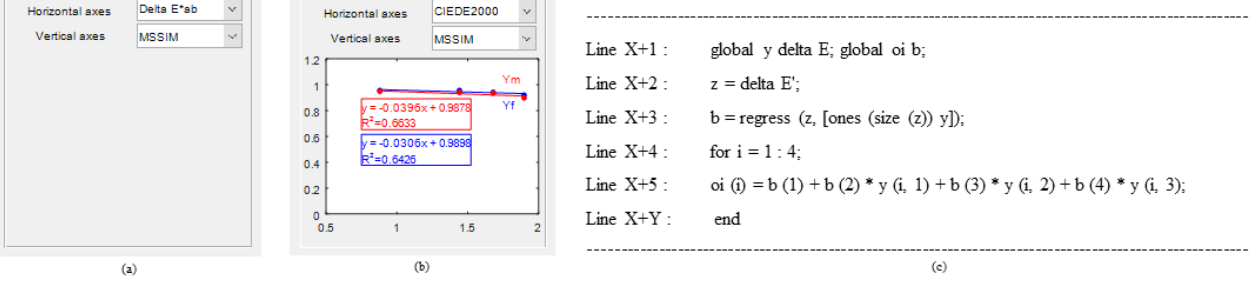
Display multiple sets of linear fit results within the coordinate